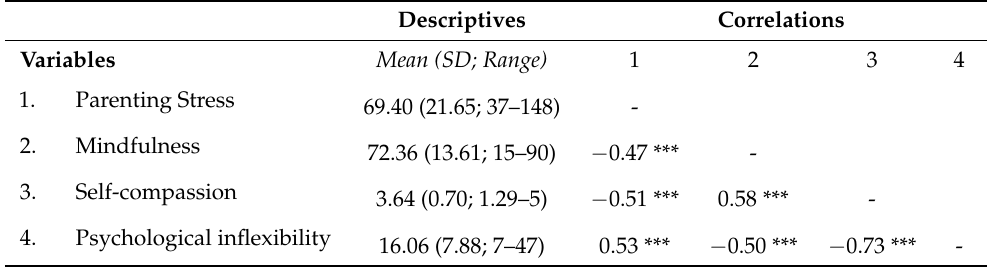
Table 2. Descriptives Statistics and Pearson’s Correlations for the Variables under